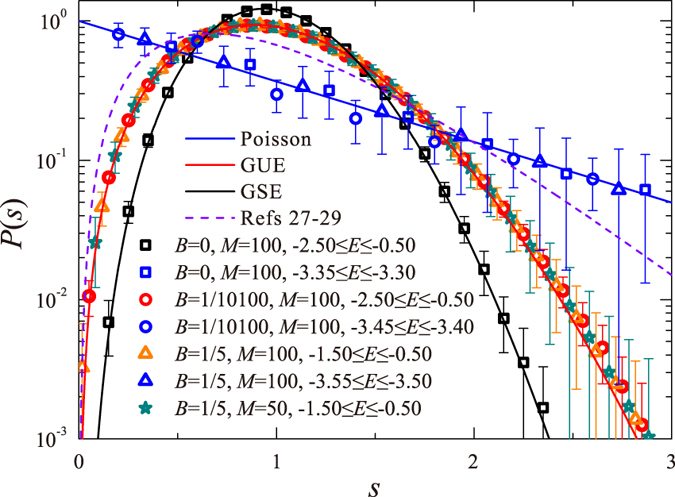
P(s) for W = 1, various magnetic field strengths B = 0, 1/10100, 1/5, various system sizes M = 50, 100, and in various energy ranges.Data are averaged over 1500 ensembles. It is evident that for B > 0 (no matter how small), P(s) corresponding to both critical and extended states fits well into the Wigner surmise for GUE (red solid line), whereas P(s) corresponding to extended states at B = 0 agree with the Wigner surmise for GSE (black solid line). The dashed line corresponds to the distribution suggested in refs 27, 28, 29 assuming ν = ∞ ⇒ γ = 1 since the localization length at a BKTT diverges faster than a power-law. For localized states with energies −3.55 ≤ E ≤ −3.50 far from BKTT mobility edge ( for B = 1/5), whose localization length is much smaller than the sample size (M = 100), P(s) agrees with the Poisson distribution (blue solid line).